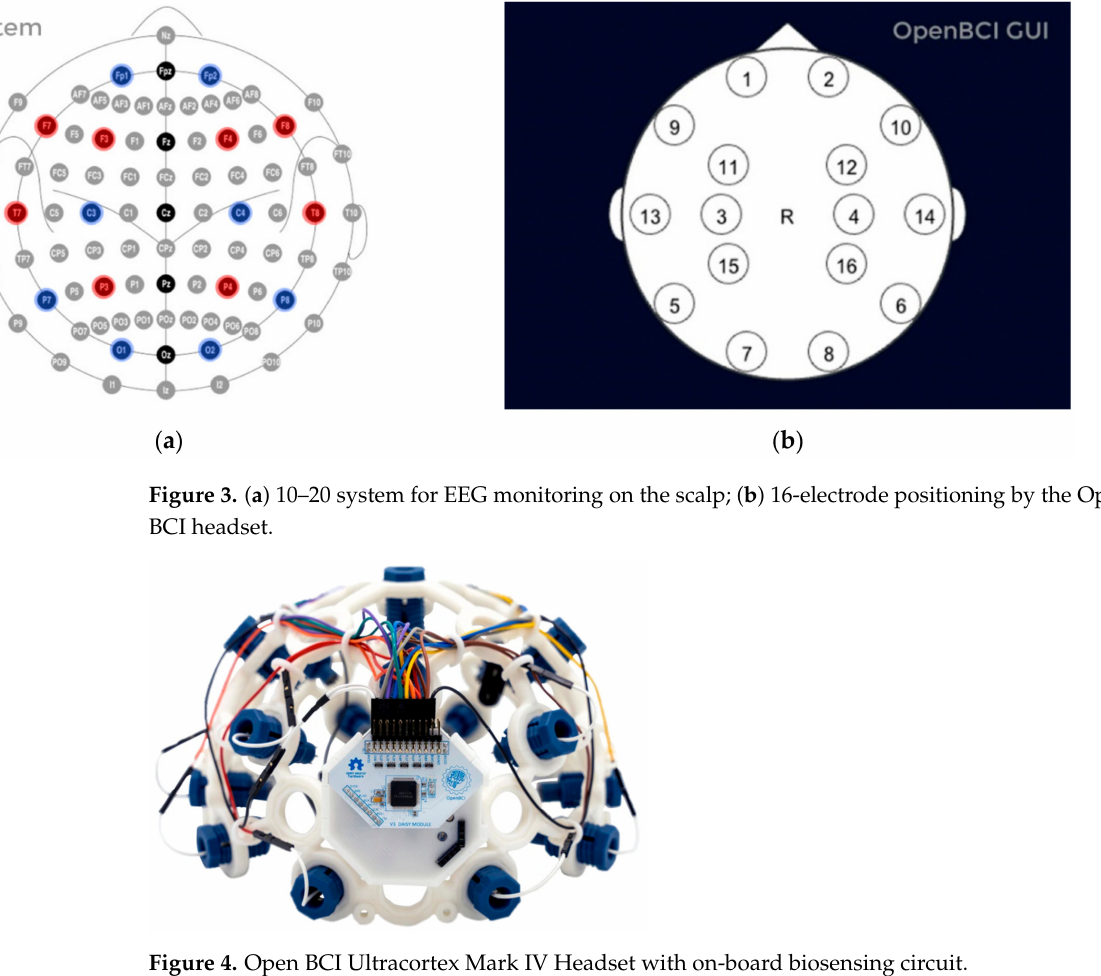
Figure 4. Open BCI Ultracortex Mark IV Headset with on-board biosensing